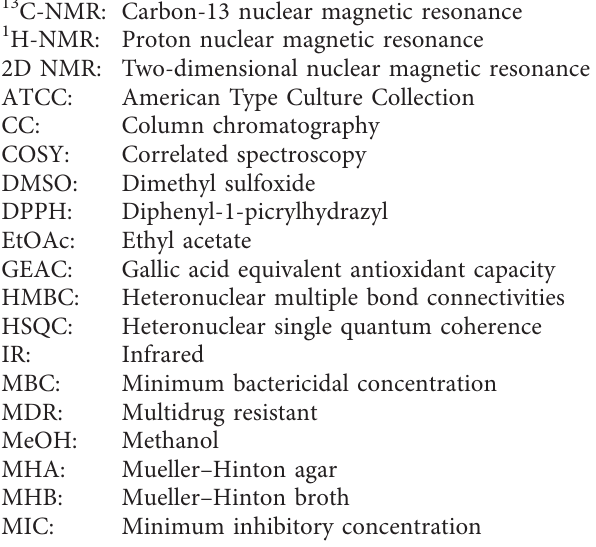
) of compound 1. Figure 3 ) of compound 1. 3 ) of 3